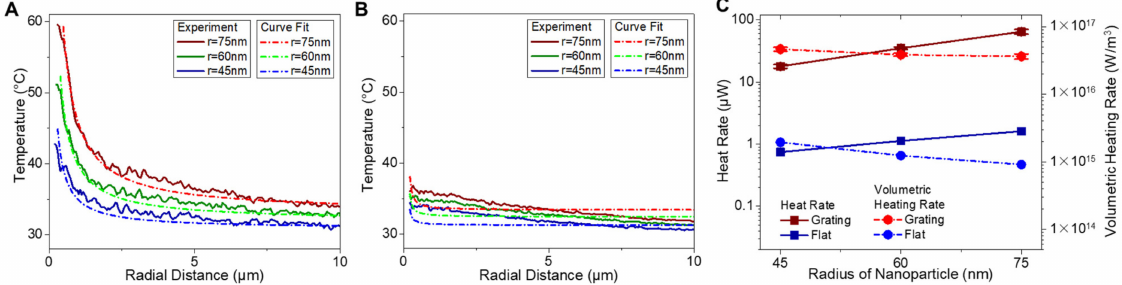
Figure 6. Steady state radial temperature profiles were obtained experimentally for photothermally heated Al NP with the radius of 45 nm, 60 nm, and 75 nm on the ( A ) grating and ( B ) flat silver substrate. The ( C ) heat generation rate and volumetric energy generation rate can be derived from the experimental temperature